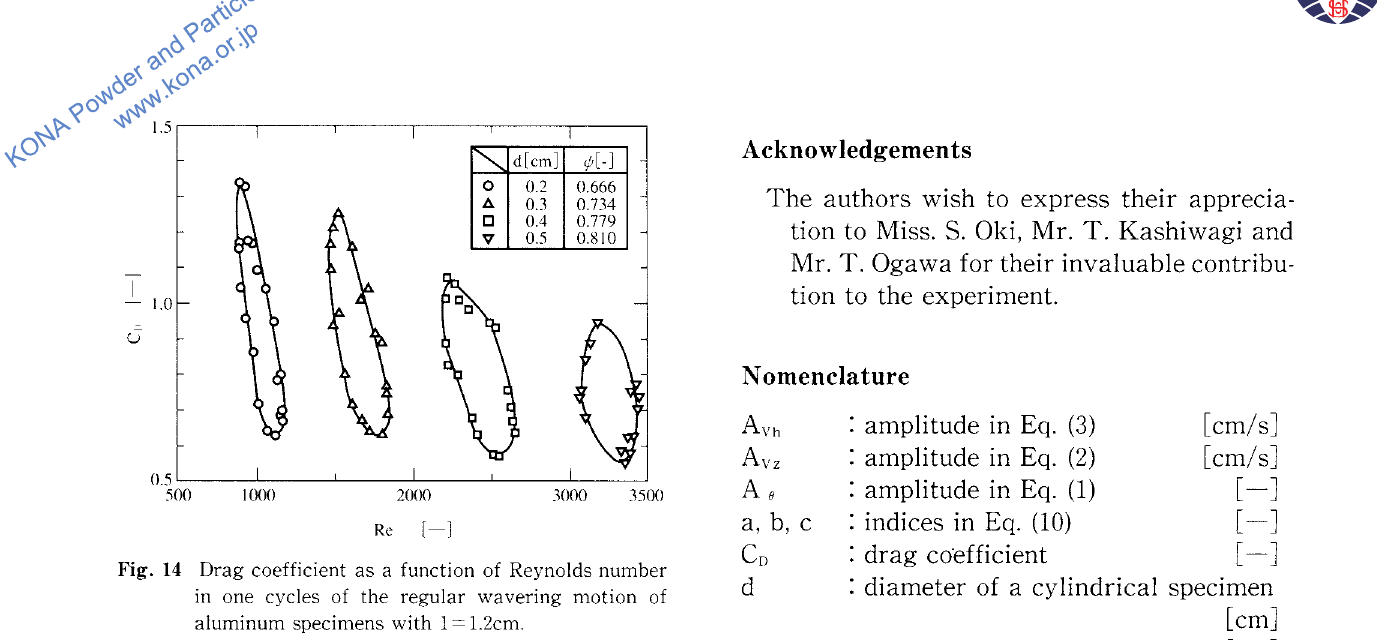
Fig. 14 Drag coefficient as a function of Reynolds number in one cycles of the regular wavering motion of aluminum specimens with 1 =